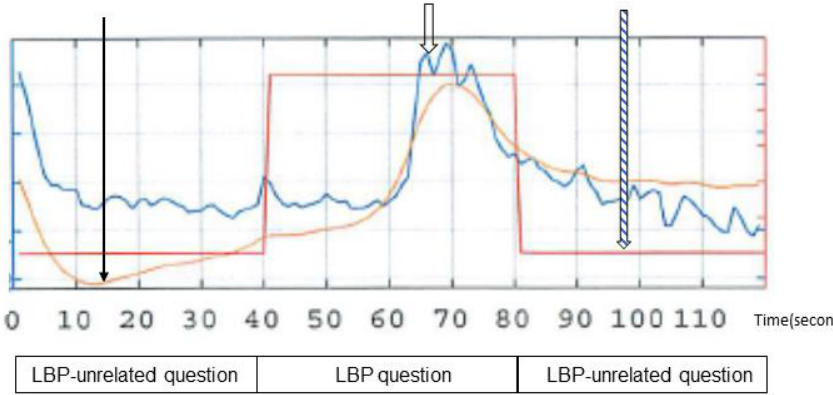
Figure 4. Typical waveforms obtained using the non-contact brain activity detection sensor. ( → ): component with band-pass filtering, ( ): component without band-pass filtering, ( ): regressor (wave showing questions related to lower back pain and questions unrelated to lower back pain-).